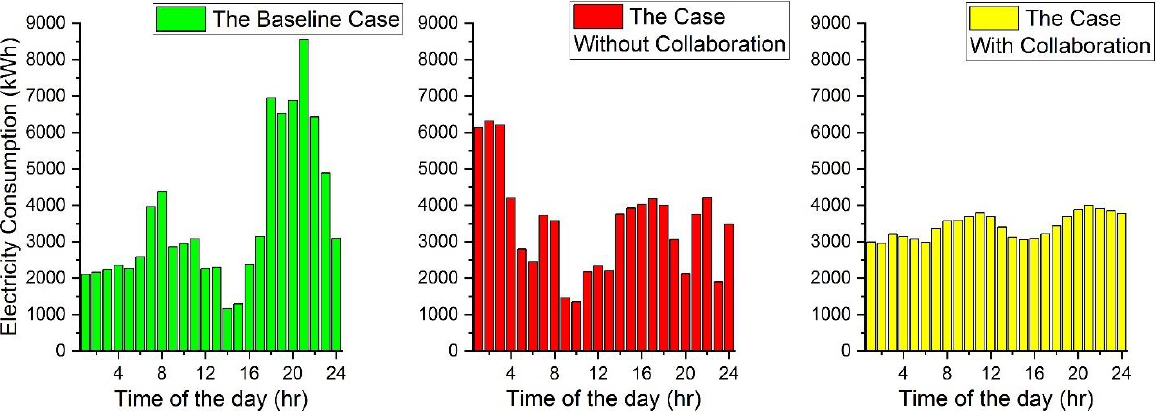
Figure 10. The comparison of total electricity demand for a large-scale building community.